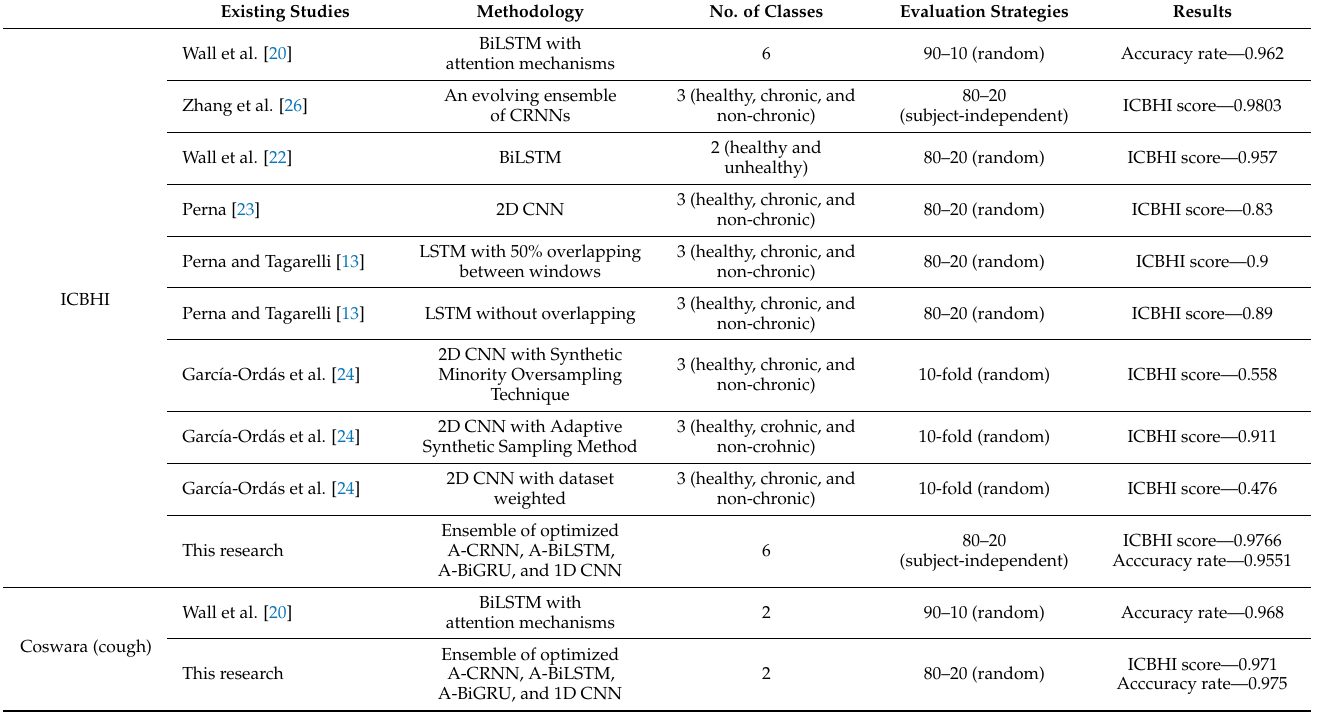
Table 25. Performance comparison with existing